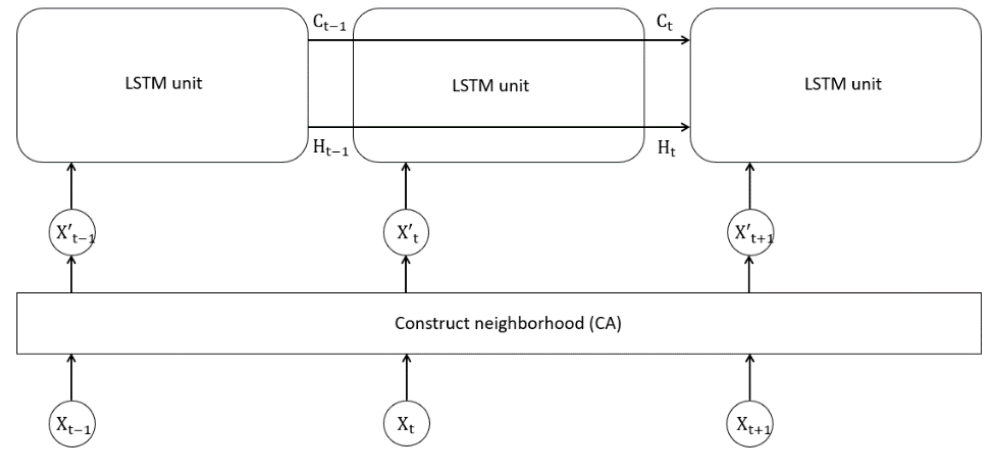
Figure 5. Schematic diagram of integrated LSTM and CA model.